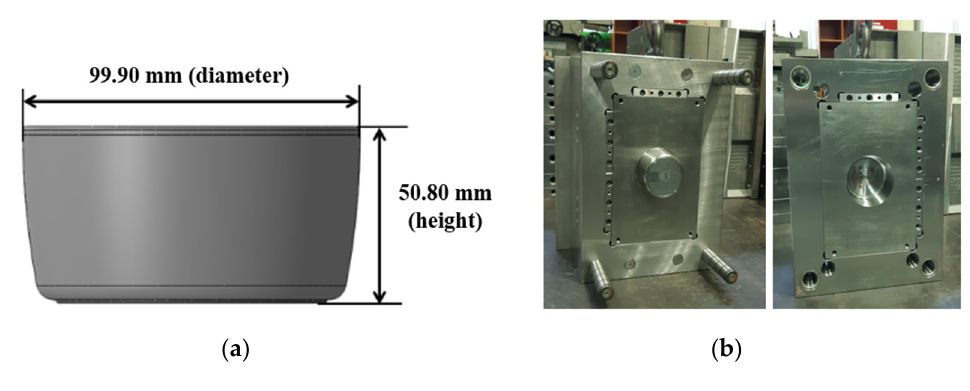
Figure 1. Images of ( a ) the rice bowl and ( b ) the mold. Table 2. General properties of the polypropylene (PP) used in this study (LUPOL GP1007F, LG Chemical Co., Ltd.).